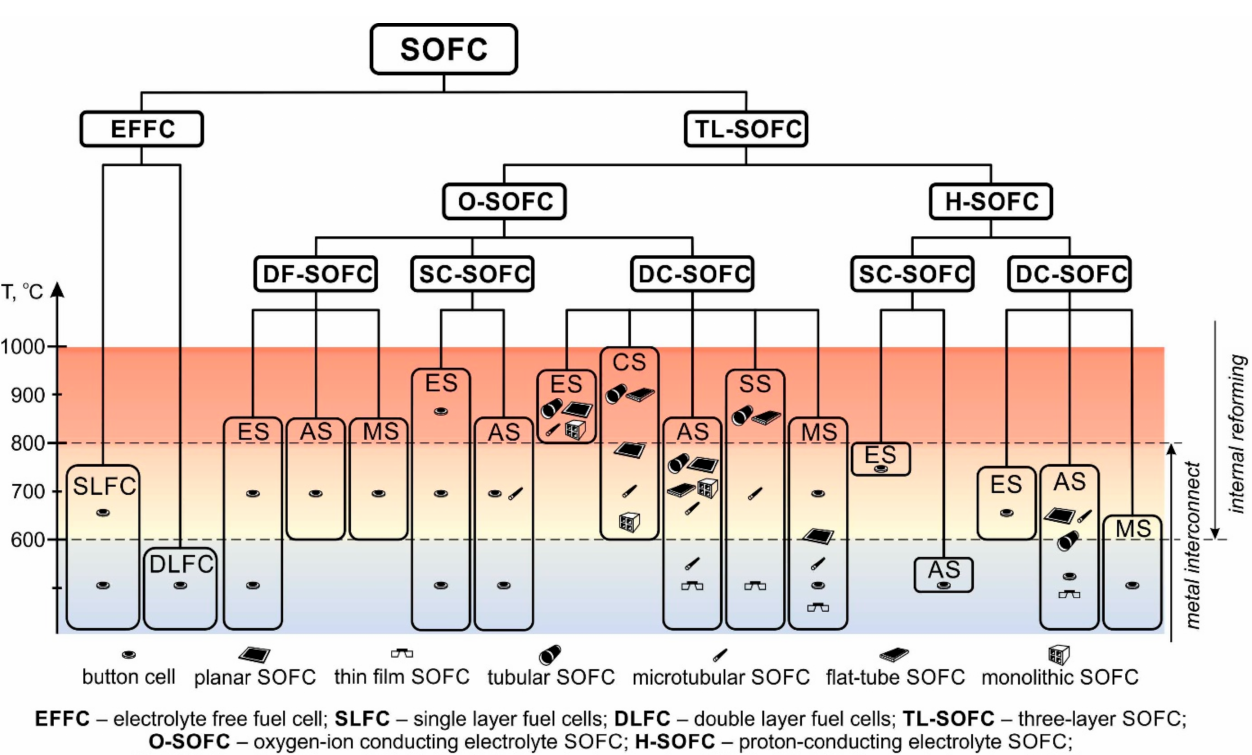
Figure 8. Systematization of SOFC types.